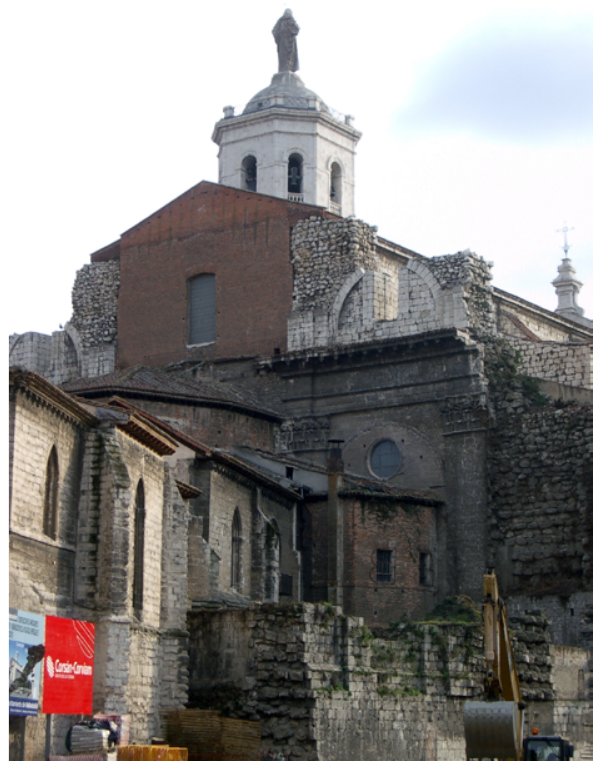
Figure 2: The incomplete Cathedral of Vallado- lid. Image from http://www.flickr.com/photos/ angeldp/2114255567/sizes/o/in/photostream/. Photo by Angeldp (Creative Commons